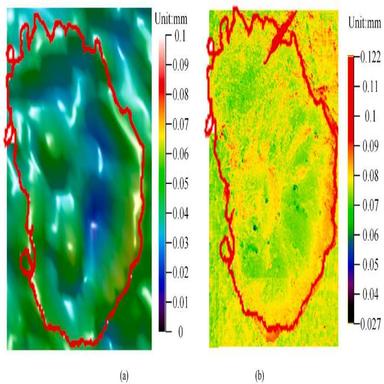
Comparison of eroded electrode surface rendering. (a) Measurement result in this paper. (b) Measurement result by CLSM.